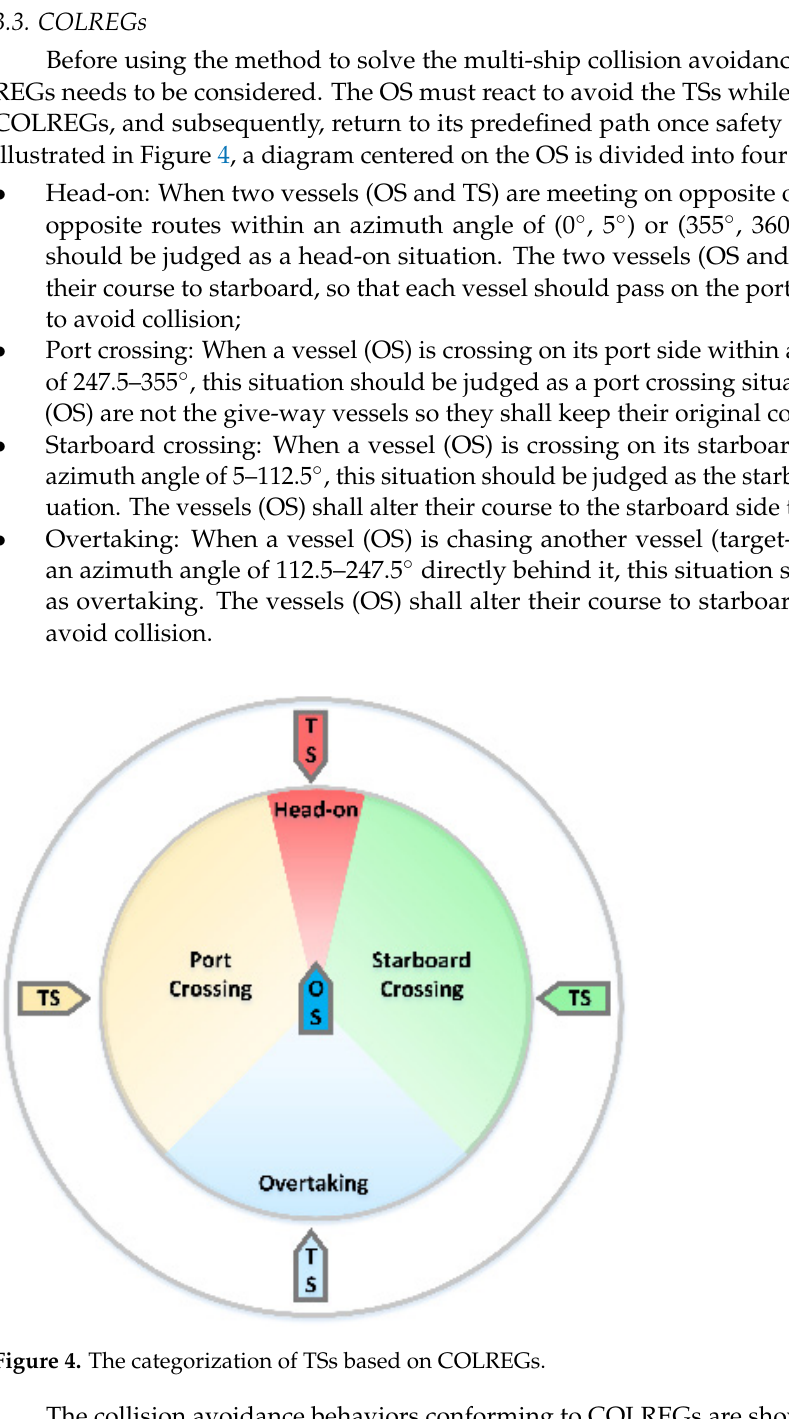
Figure 5. Encounter situations defined by COLREGs. 3.4. COLREGs-Based Multi-Ship Collision Avoidance The COLREGs can be extended to scenarios where OS encounters multiple TSs. The multi-ship collision avoidance under the COLREGs can be summarized as Figure 6. In Figure 6, the OS encounters two TSs in different directions, they should all comply with COLREGs and alter course to starboard to avoid collision. In the same way, when three ships encounter a similar situation, they should all alter course to starboard. In sum- mary, when a multi-ship (